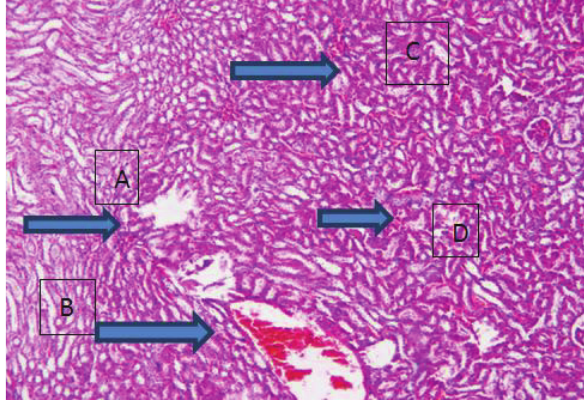
Fig-5: Showing damage of kidney in group 5 received combined extract of BV and